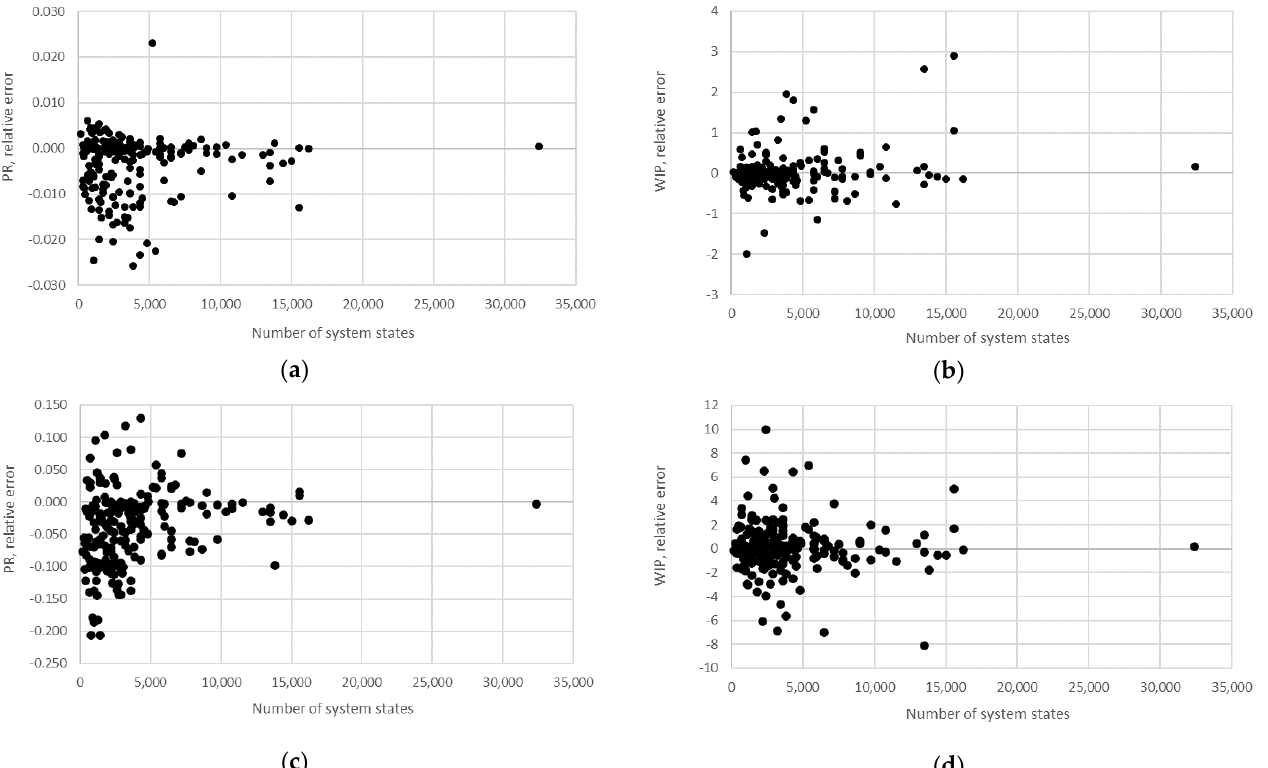
Figure 15. M = 6, relative error obtained using the ( a , b ) AGG procedure and ( c , d ) FSM.